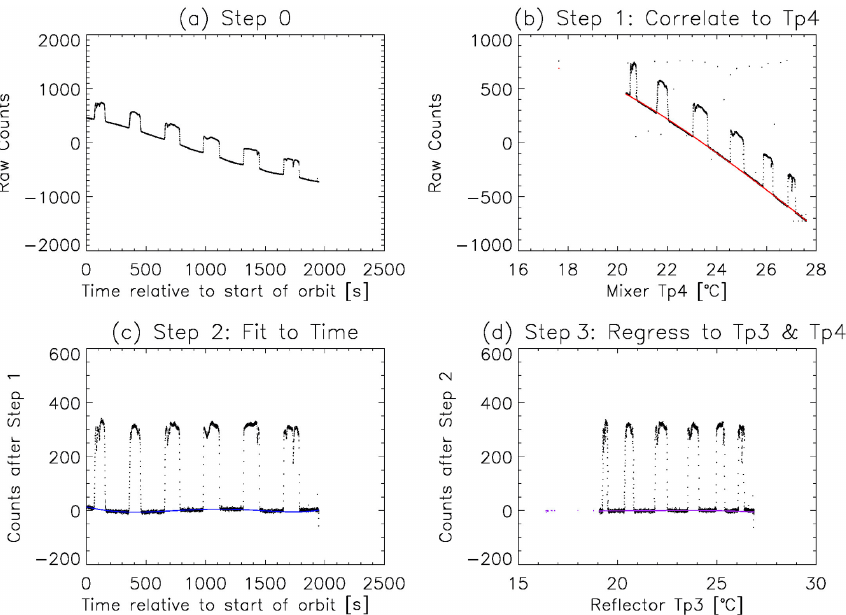
Figure 2. An example showing the four steps of relative calibration: (a) raw total counts ( C ), (b) raw counts polynomial fitting to Tp 4 (red) can largely capture the C sp variation, (c) count residuals polynomial fitting to relative time (blue), and (d) count residuals polynomial fitting to Tp 3 and Tp 4 (purple). After these four steps, standard deviation of C sp decreased to about four counts. This orbit is taken from the first orbit of IceCube on 14 August 2017.